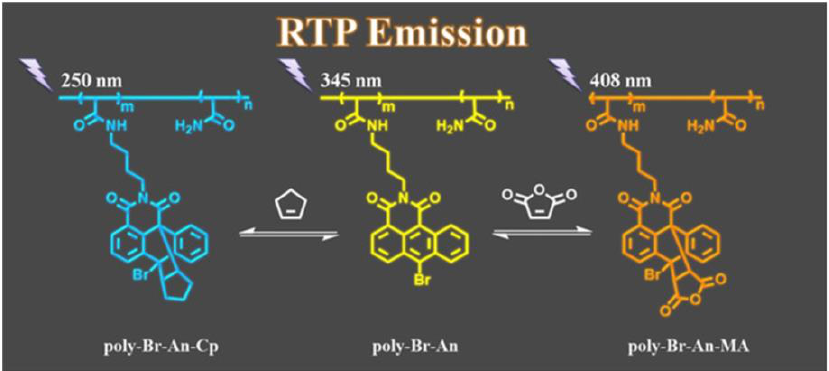
Figure 8. The structures of three organic room-temperature phosphorescence polymers in Ref. [81]. Reprinted with permission from Ref. [81]. Copyright 2020, Wiley-VCH.